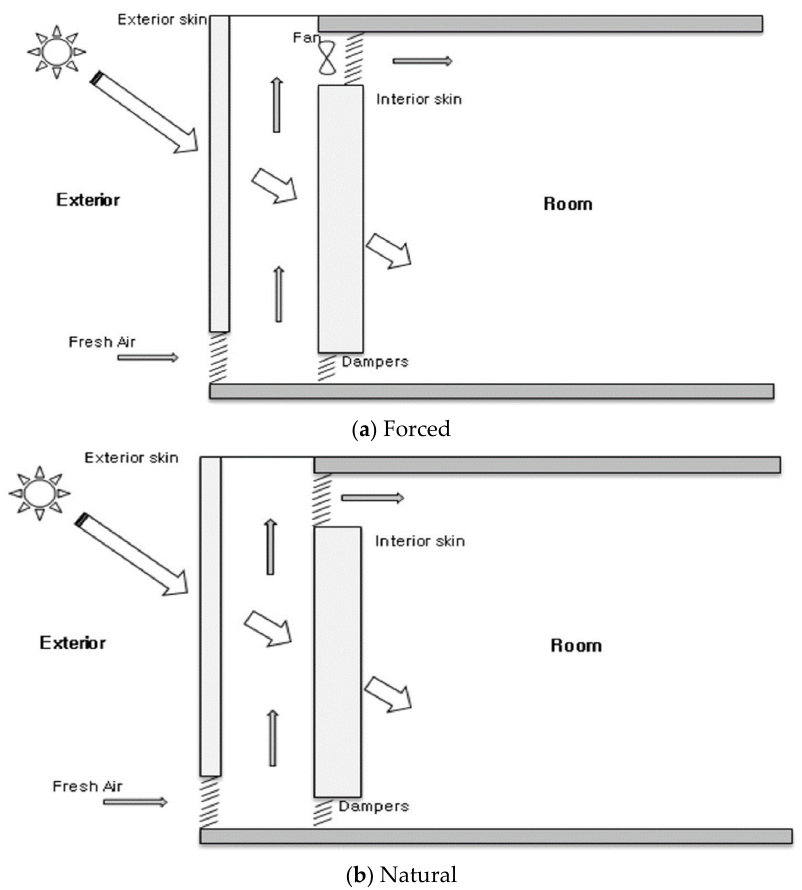
Figure 3. Schematic presentation of the DSF ( a ) forced ( b ) natural